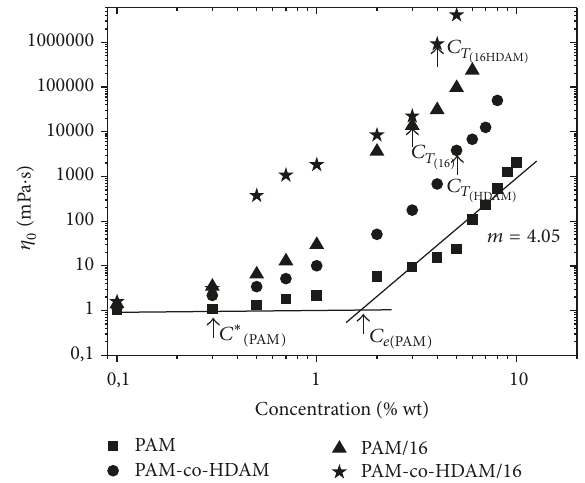
Figure 13: Variation of zero-shear viscosity ( 𝜂 0 ) as a function of polymer concentration ( 𝐶 ), for the synthesized polymers using the linear C12 hydrophobic group.